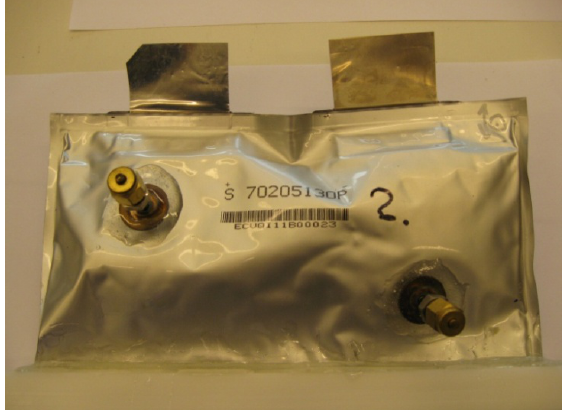
Figure 7. The Swagelok connector on the left in picture was used as inlet for dry nitrogen. The right connector was the outlet for nitrogen gas which was directed to the detector in the Mocon